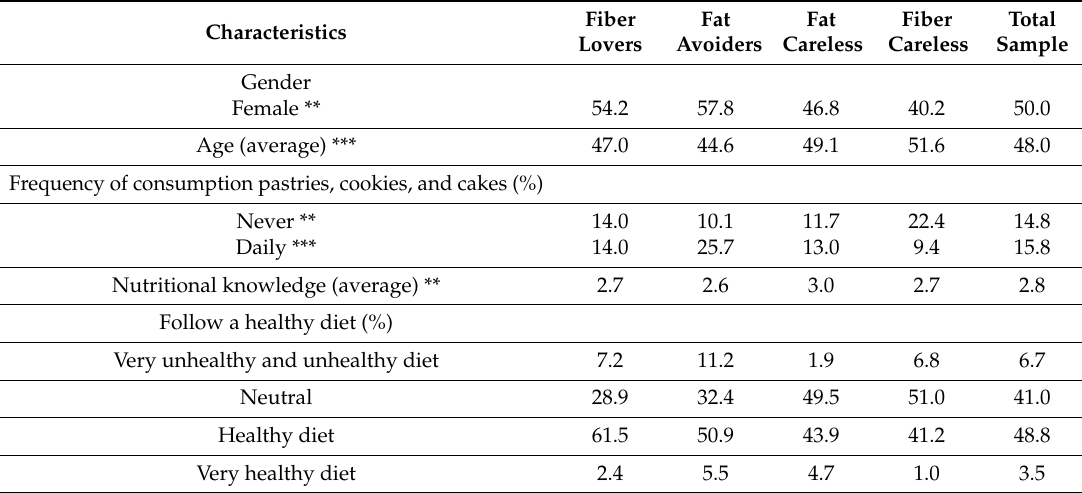
Table 8. Biscuits: Profiling consumer segments (%, unless